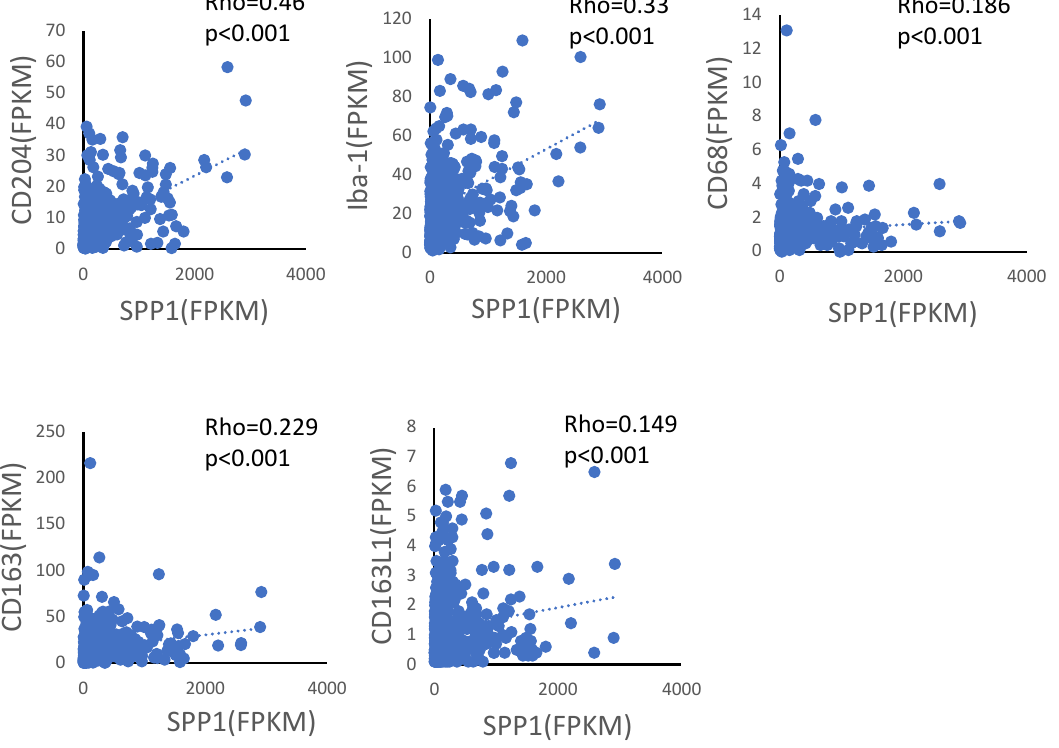
Figure 5. Correlation diagram between SPP1 gene expression and other macrophage markers (CD204, Iba-1, CD68, CD163, and CD163L1) in lung adenocarcinoma tissues using gene expression data from The Cancer Genome Atlas (https://www.proteinatlas.org/ (accessed on 16 June